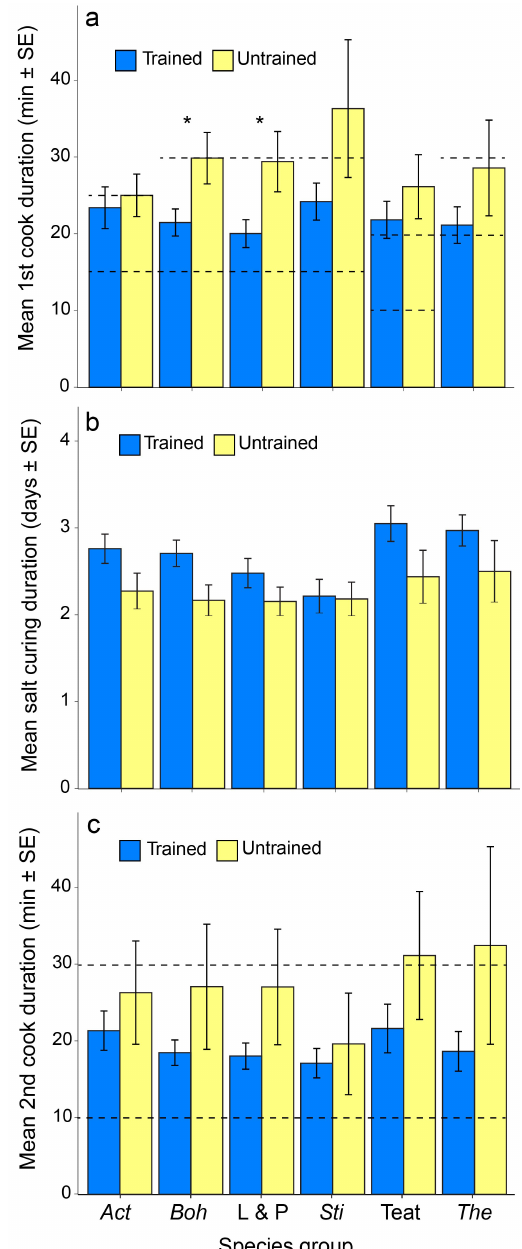
Fig. 3 . Individual- and community-scale (underlined) socioeconomic characteristics and their relationship to (a) adoption of new methods by trained fishers (n = 46); and (b) knowledge sharing by trained fishers (n = 53). Parameter estimates are highest posterior density medians (black dots) and associated 95% uncertainty intervals (UIs), estimated from Bayesian hierarchical linear models. Estimates to the right of the dashed line indicate that the variable was positively related to adoption or knowledge sharing. Reference category: Gender, “Female”; Dependence, “No”.